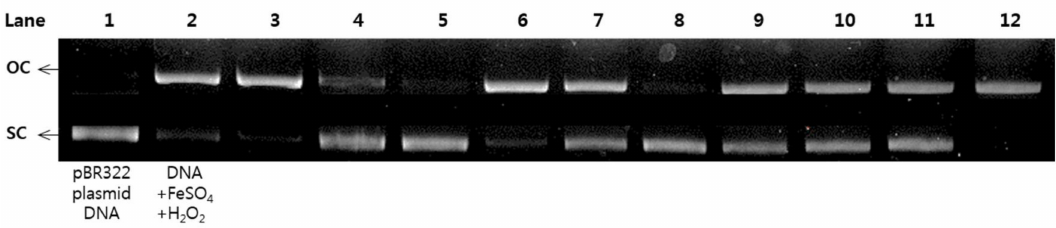
Figure 5. Protective effect of metabolites ( 1 – 9 ) against pBR322 DNA cleavage induced by hydroxyl radical oxidative injury. Lane 1: pBR322 plasmid DNA control; lane 2: pBR322 DNA + 1 mM FeSO 4 + 30% H 2 O 2